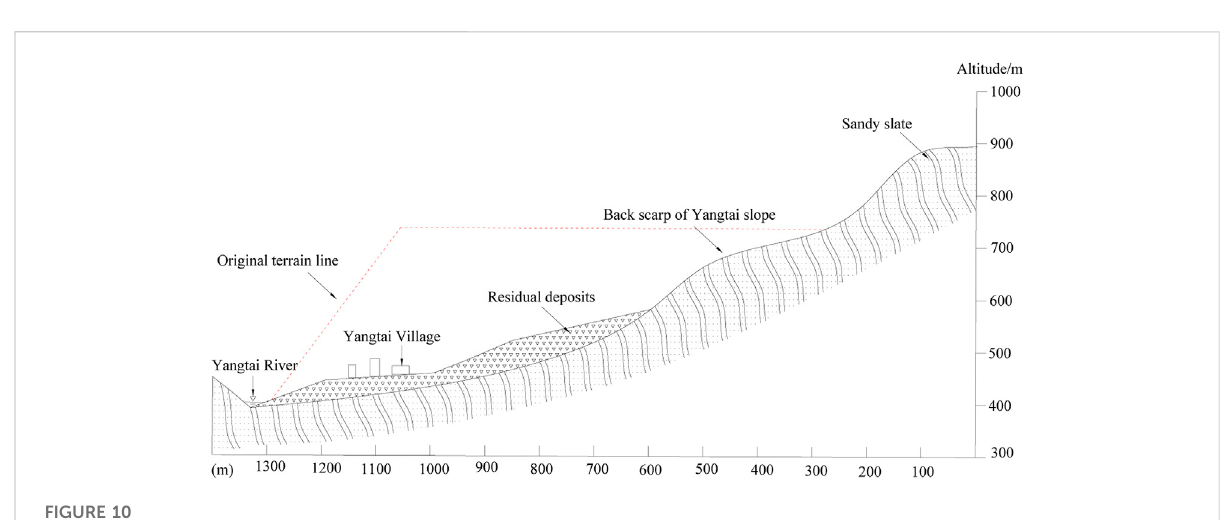
FIGURE 10 Engineering geological pro fi le of Yangtai